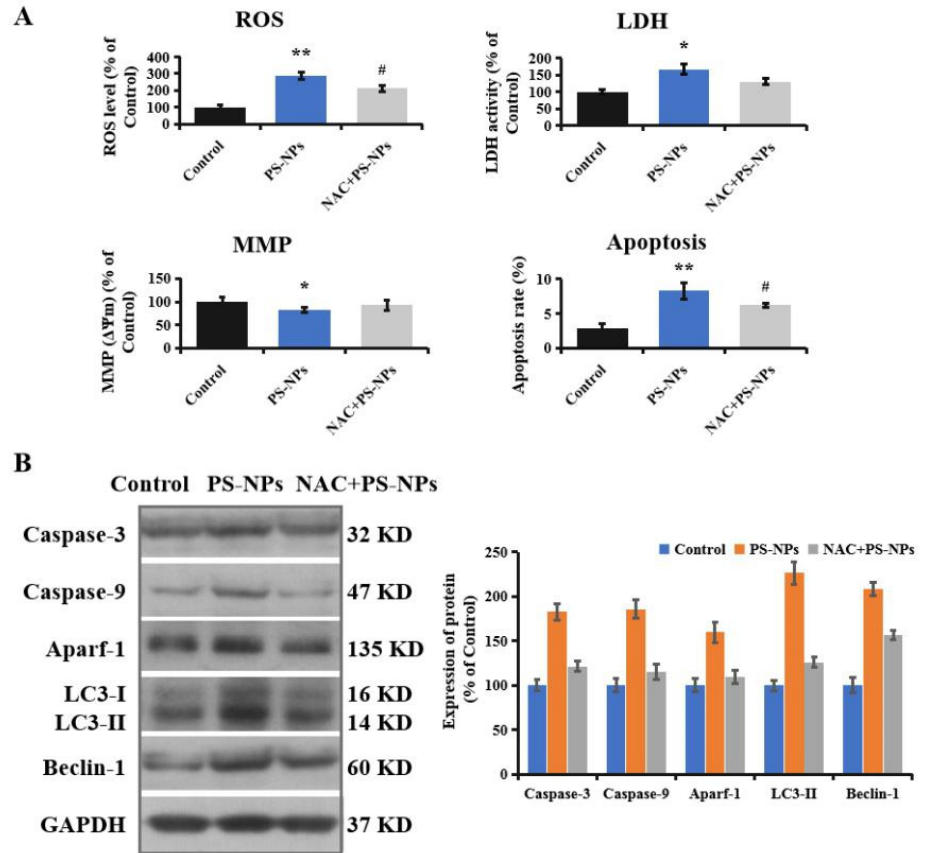
Figure 5. Oxidative stress regulated autophagy and neurotoxicity induced by PS-NPs. SHSY-5Y cells were pretreated with NAC (5 mM) for 4 h and then treated with 200 mg/L of PS-NPs for 24 h. ( A ): The ROS level, LDH activity, MMP, and apoptosis rate were measured. ( B ): The expression of apoptosis and autophagy-related proteins were measured with Western blotting, and the expressions of proteins were quantified. In the control group, SHSY-5Y cells were only treated with medium. * p < 0.05 and ** p < 0.01, compared to the control. # p < 0.05, NAC+PS-NPs group compared to the PS-NPs group.